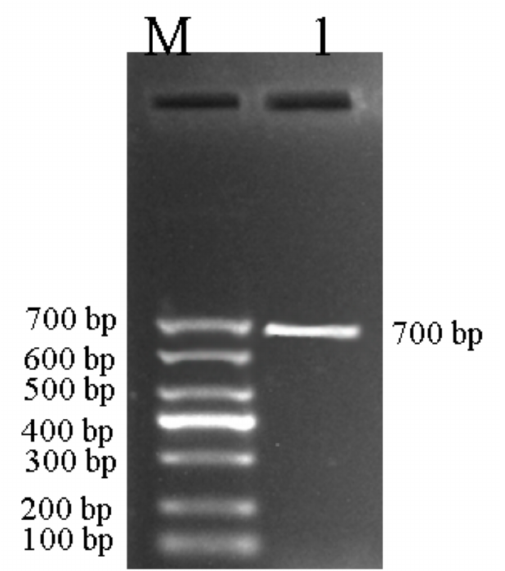
Figure 2. Agarose gel electrophoresis of PCR expansion of ITS sequence of C. beticola . M: DNA Marker I, the ladder was fabricated by Beijng Zoman Biotechnology Co., Ltd., Beijing, China; 1: ITS sequences of C. beticola , 700